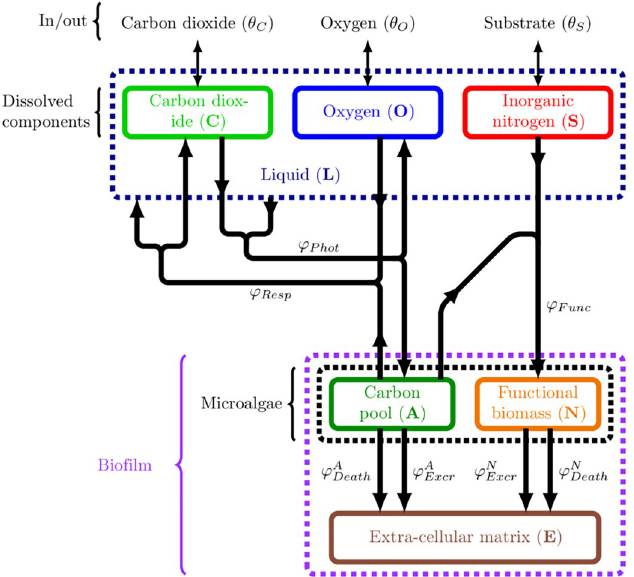
Fig 1. Schematic representation of the biological model scheme, including the external supplies and the metabolic pathways. The arrows represent the mass exchanges induced by biochemical reactions between the components which are represented by the